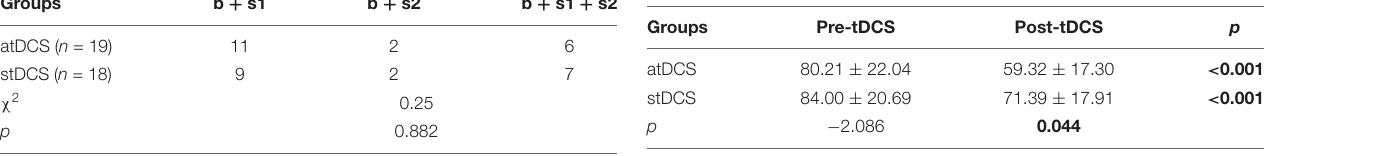
TABLE 3 | Evaluation results of the ABC scale pre- and post-tDCS in the two groups.